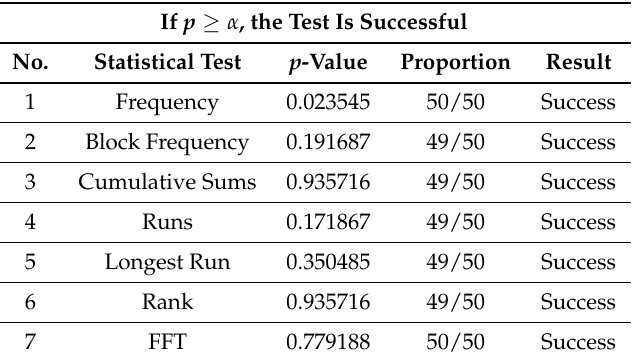
Table 1. NIST statistical test results, if p ≥ 0.01, the test is